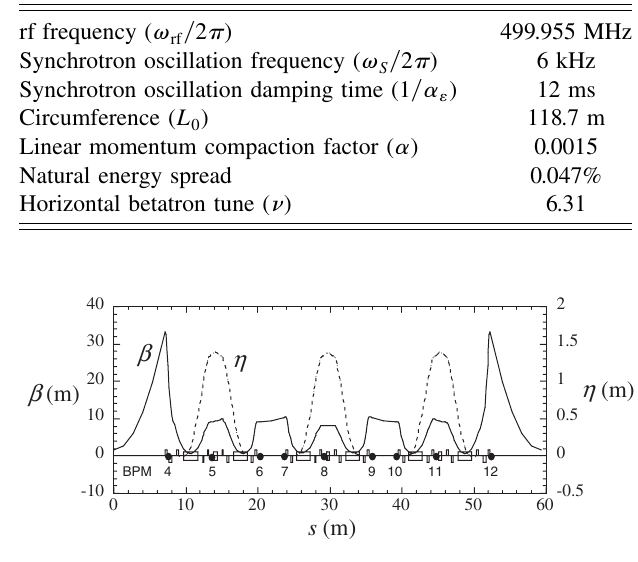
FIG. 1. The horizontal beta function ( (cid:5) , solid line) and dis- persion function ( (cid:9) , broken line) in the eastern half of the NewSUBARU ring. The boxes indicate the locations and lengths of the bending magnets and quadrupole magnets. The numbered black circles point out BPM (beam position monitors)